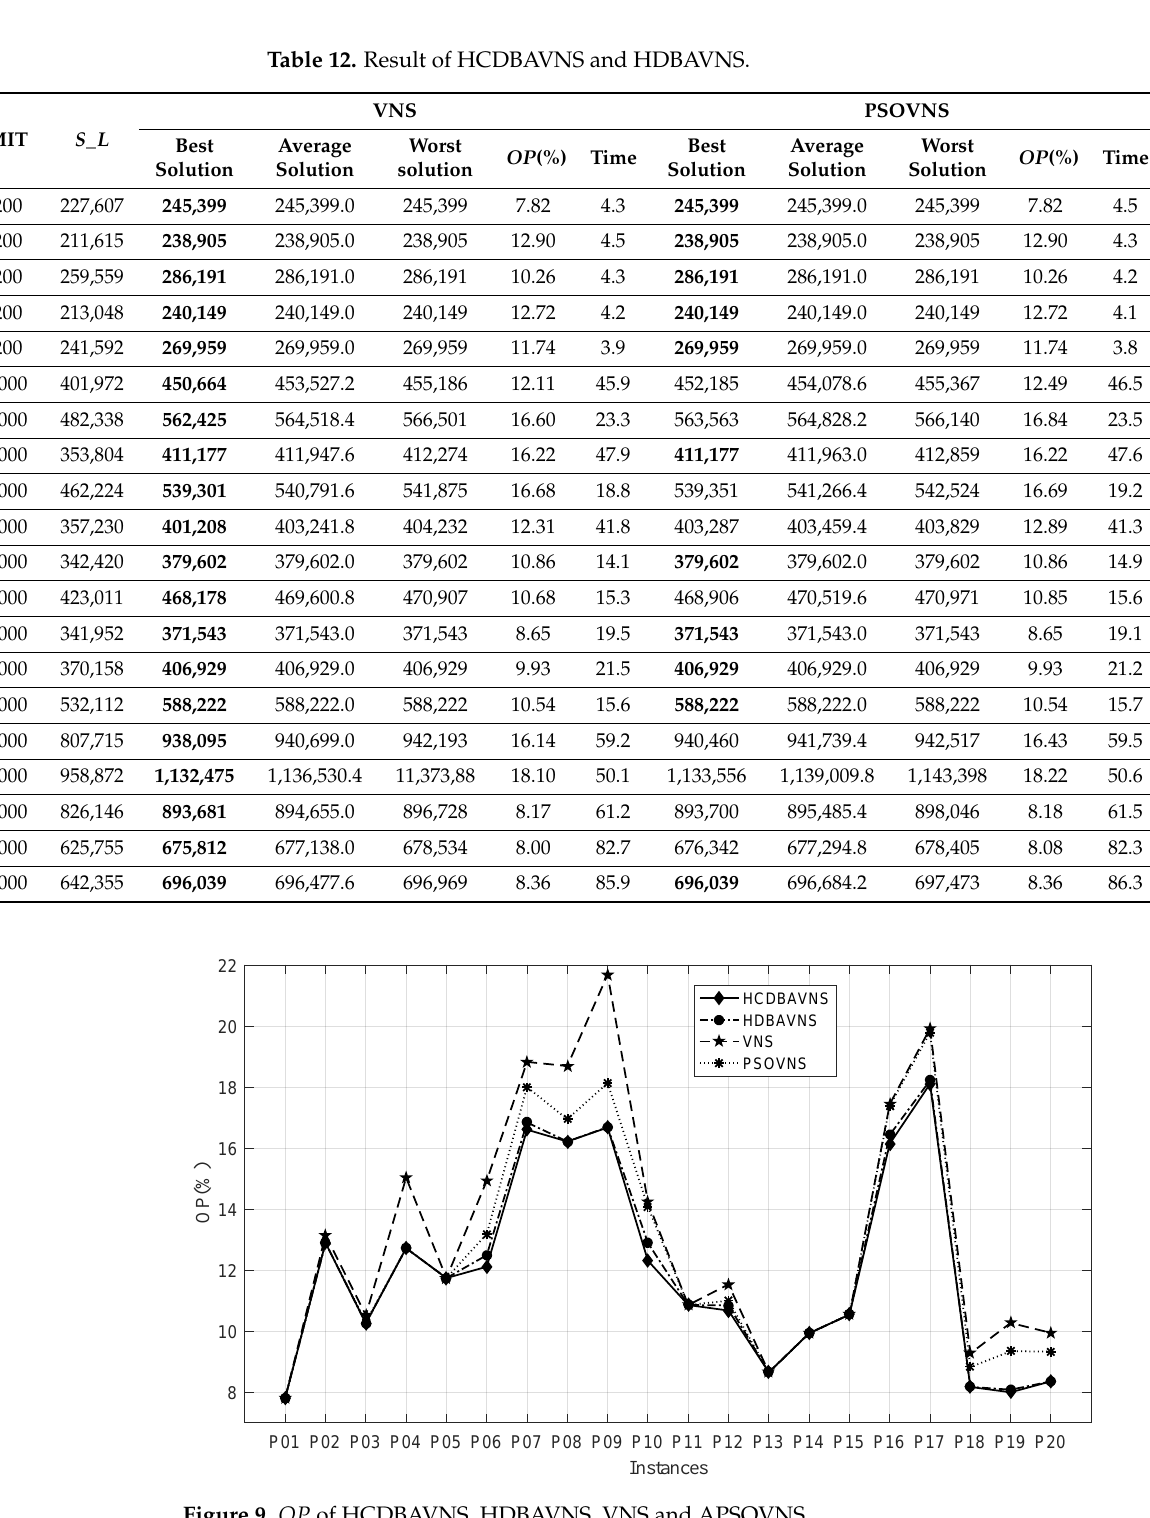
Figure 9. OP of HCDBAVNS, HDBAVNS, VNS and